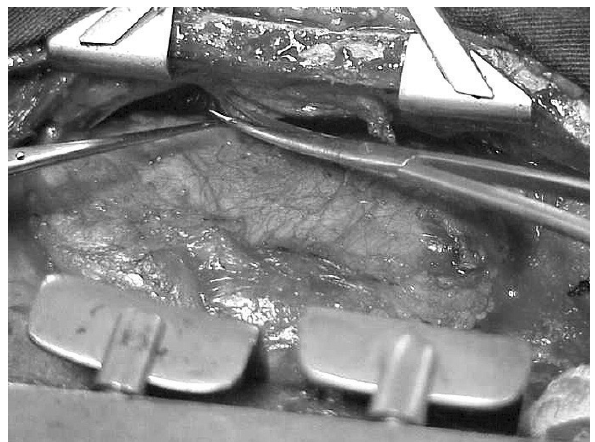
Fig.1 - Abertura da fáscia endotorácica com tesoura, expondo a artéria e veias satélites